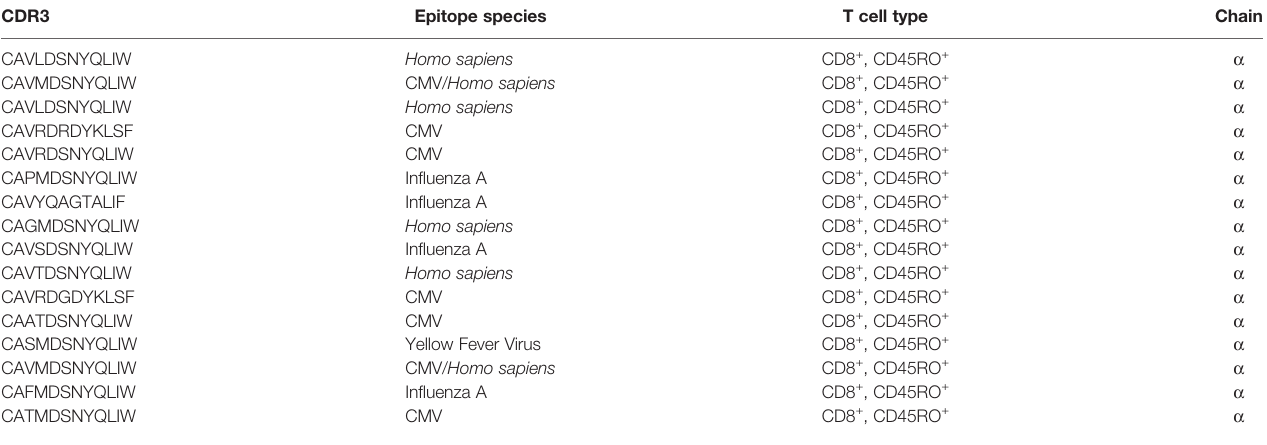
TABLE 2 | VDJ database annotated CDR3s from memory CD8 + T cells shared between all four PTI patients CDR3 Epitope species T cell type